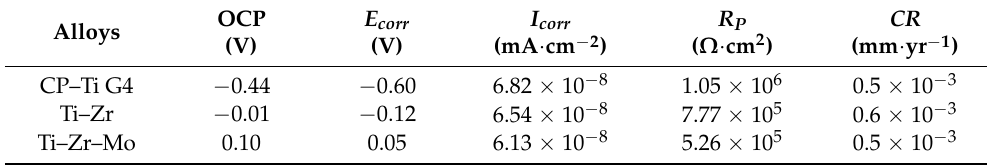
Table 2. Electrochemical parameters obtained from linear polarization curves of the alloys studied in PBS. Alloys